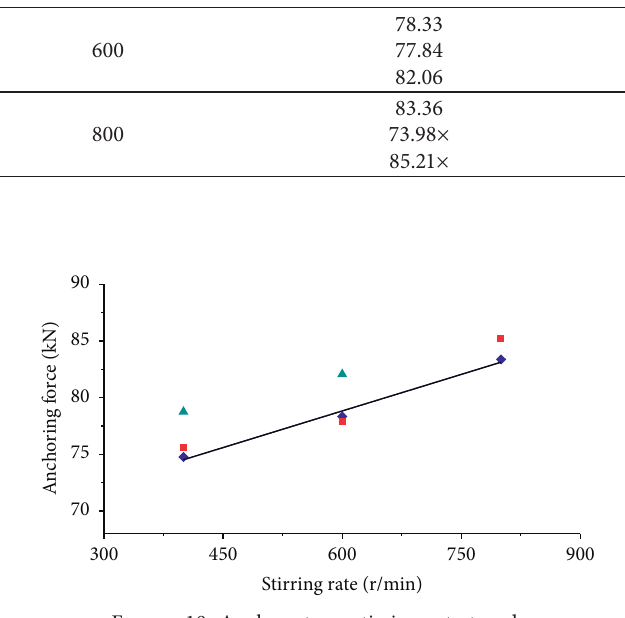
Figure 18: Anchor stress-stirring rate trend.